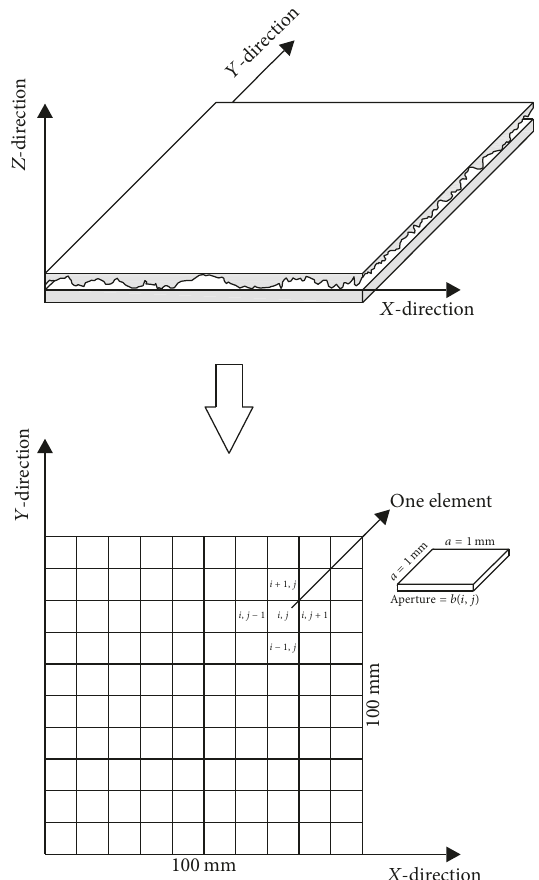
Figure 1: Two-dimensional lattice-grid model for the horizontal